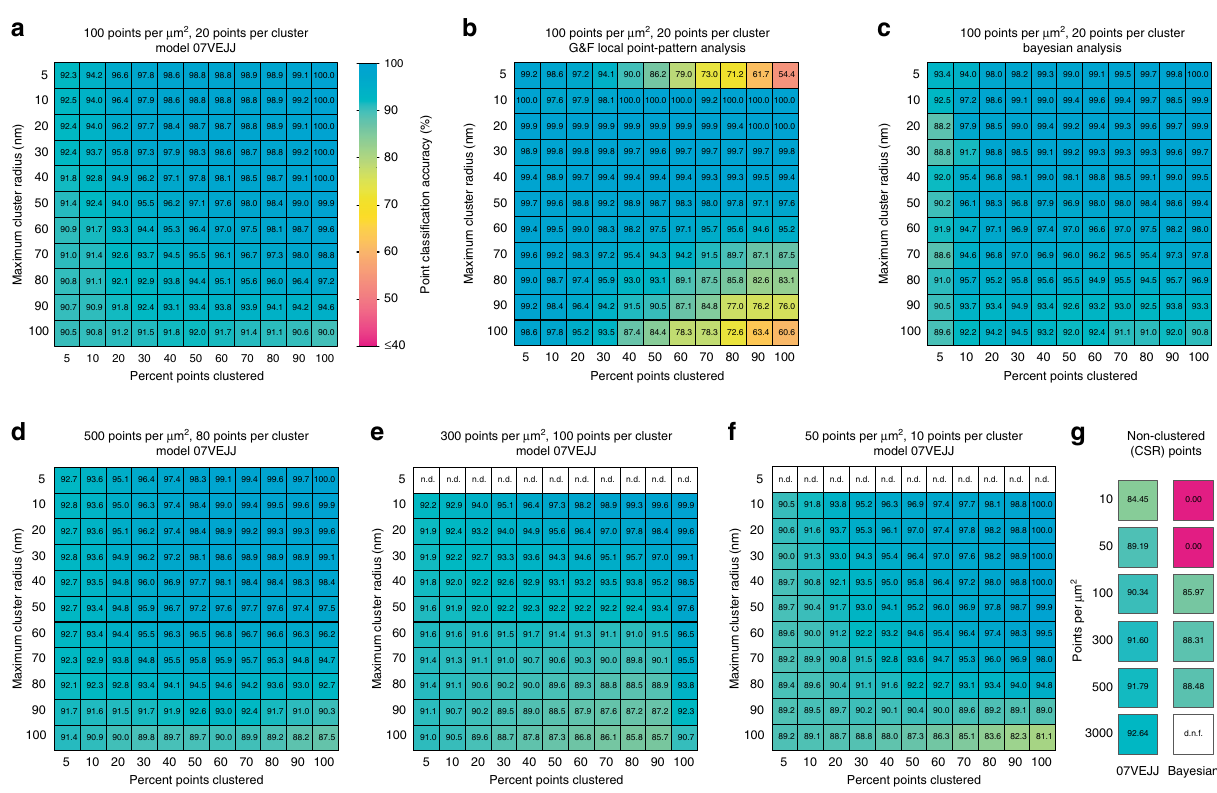
Fig. 3 Classi fi cation accuracy of simulated data. Data were assessed with a model 07VEJJ, or b Getis & Franklin ’ s Local Point Pattern Analysis, or c Bayesian Cluster Analysis on 3 × 3 μ m centered regions extracted from the data sets analyzed by a and b . Model 07VEJJ shows comparable performance at very high point densities ( d ), when the number of points per cluster matches the limit of the models near-neighbor distances ‘ reach ’ ( e ) (n.d. = not determined), and very low point densities ( f ). g Classi fi cation accuracy for completely spatially random data at different point densities analyzed by Model 07VEJJ or the Bayesian method; d.n.f. = did not fi nish. Data are mean values from ten